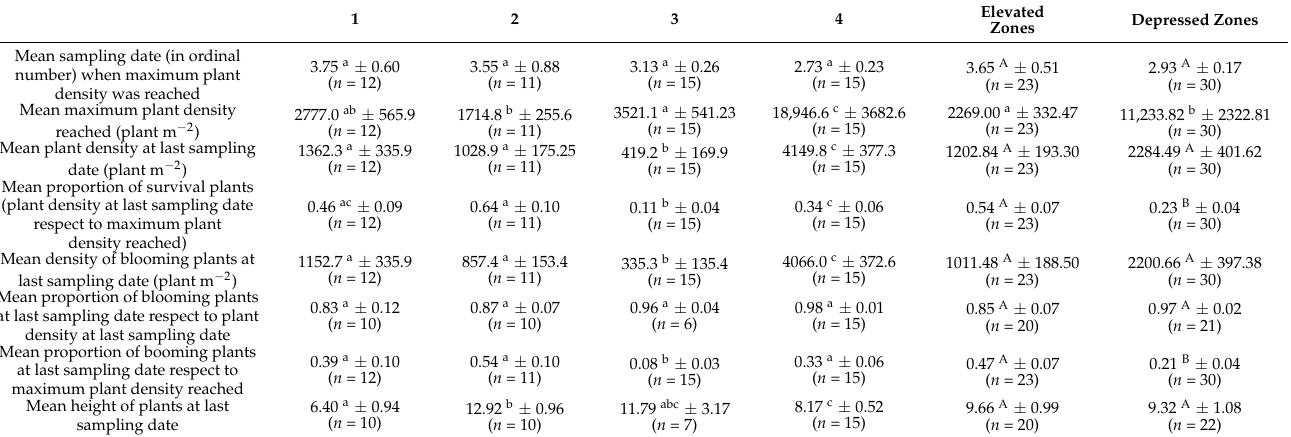
Table 3. Population parameters for four populations of Salicornia ramosissima , and for populations in elevated and depressed zones. Different letters indicate significant differences among populations (Kruskall–Wallis test, p < 0.05) or between physiographic zones (Mann–Whitney test, p < 0.05). Values are mean ± SE.